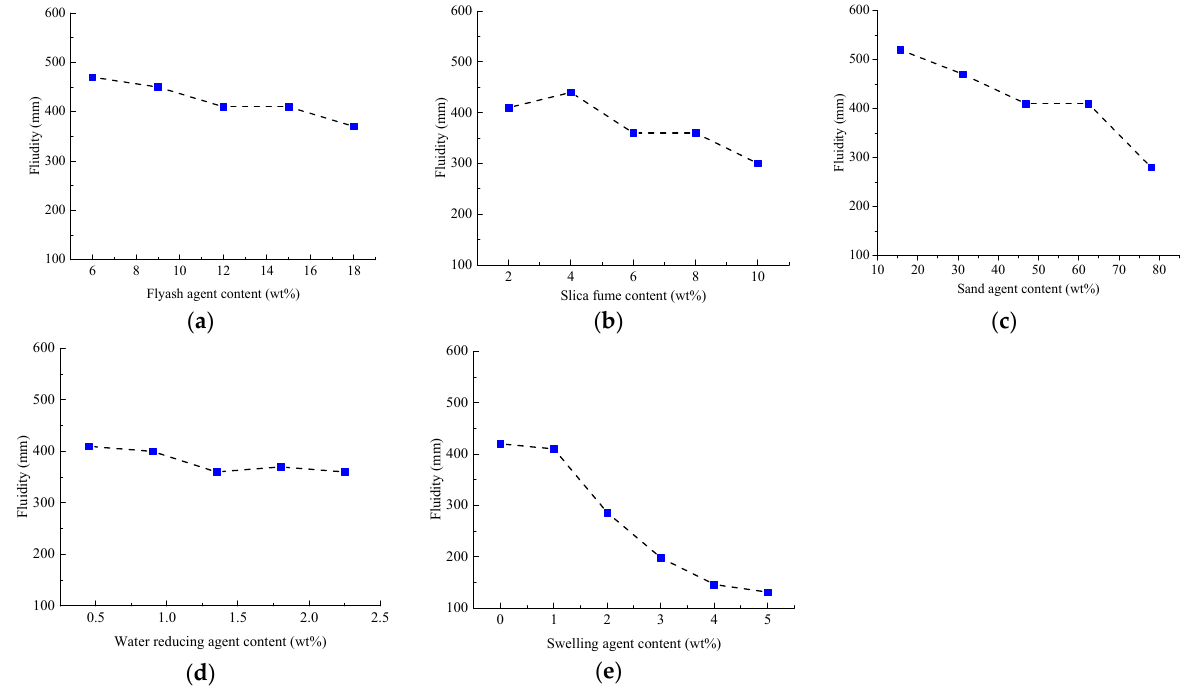
Figure 10. The influence of the content of different components on fluidity ( a ): fly ash; ( b ) silica fume; ( c ) sand; ( d ) water reducing agent; ( e ) expansion agent.